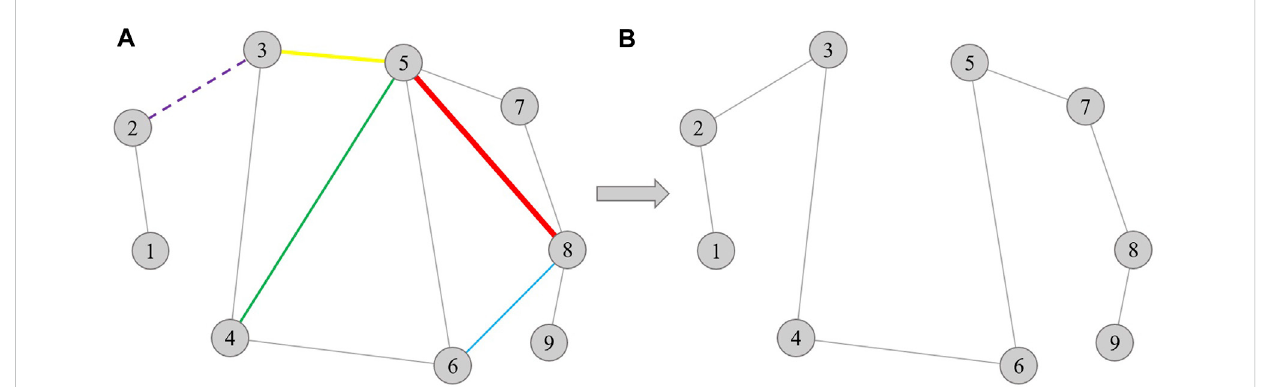
FIGURE 3 An example showing the effect of removing edges on network connectivity. (A) shows the initial network which consists of 9 nodes and 12 edges. Thethicknessofthesecoloredsolidlinescorrespondstothe C D oftheedge,thederivedsetaccordingto C D indescendingorderis e 58 , e 35 , e 45 , e 68 { } .The purple dot line indicates the edge with the largest EBC. (B) shows the network after removing e 58 , e 35 , e 45 , e 68 { } .